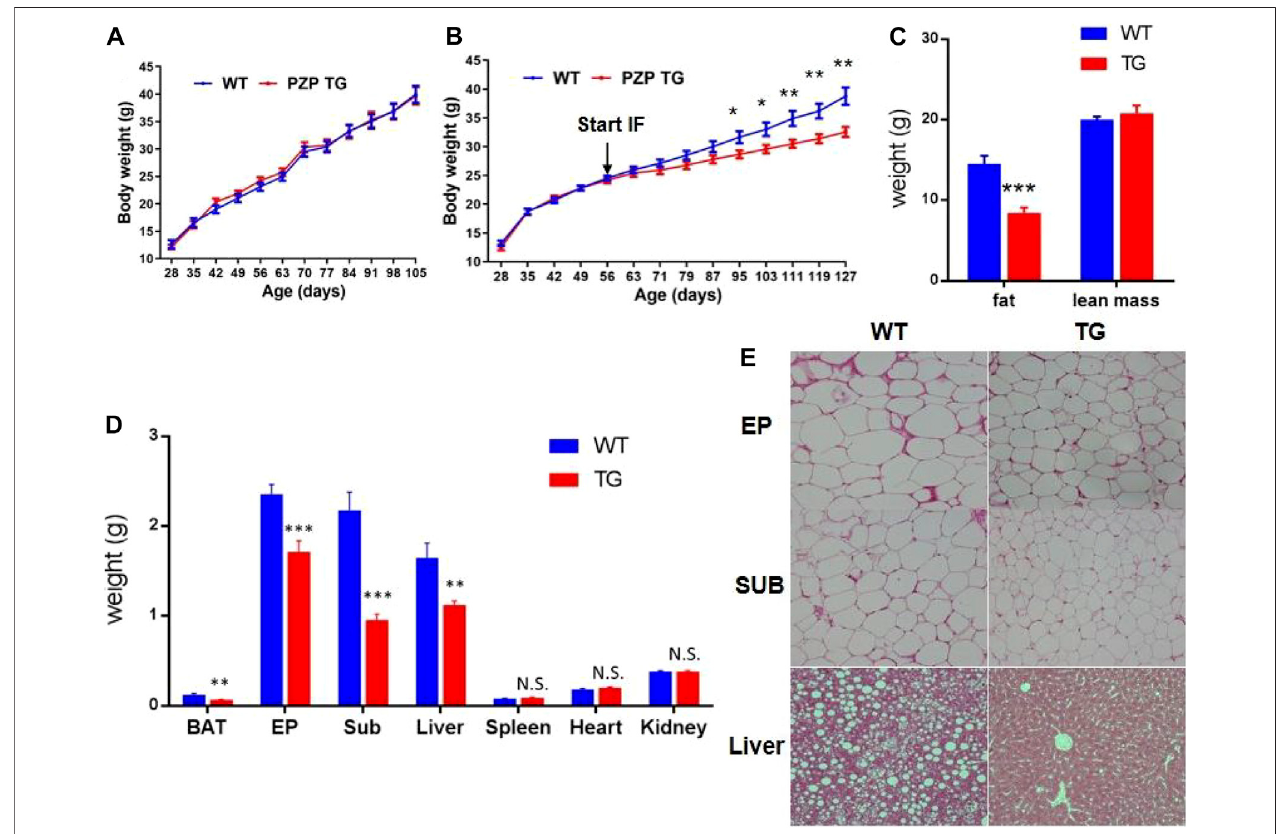
FIGURE1| Anti-obesityeffectofIFRisenhancedinPZPTGmice. (A) BodyweightofWTandPZPTGmiceunderHFD( n =10). (B) BodyweightofWTandPZPTG mice under HFD and IF ( n = 12). (C) Body composition of WT and PZP TG mice when mice were fed on HFD and IF for 12 weeks ( n = 11). (D) Tissue weight of WT and PZPTGmice( n =8). (E) Representativehematoxylin – eosin(HE)stainingimagesofiWAT,eWAT,andliverfromWTandPZPTGmiceshowingthatPZPTGmiceunderIF conditions had smaller adipocytes and less lipid accumulation in the liver (scale bar = 100 μ m).